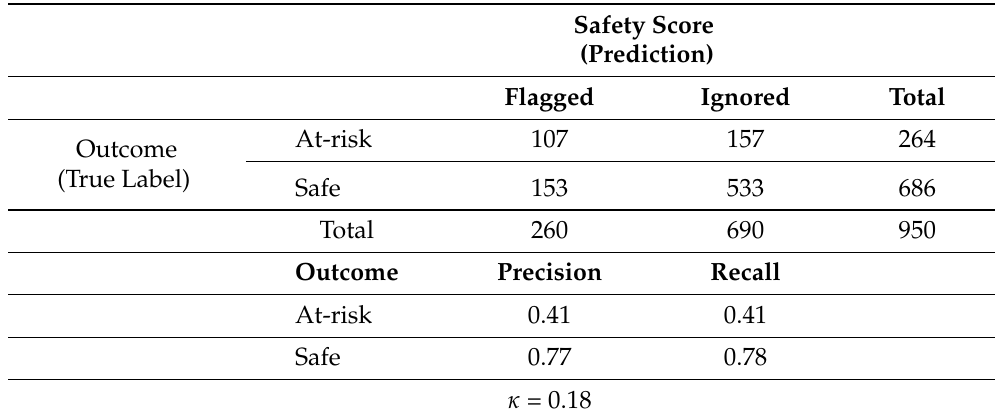
Table 12. Confusion matrix and summary of Background–Grade test set